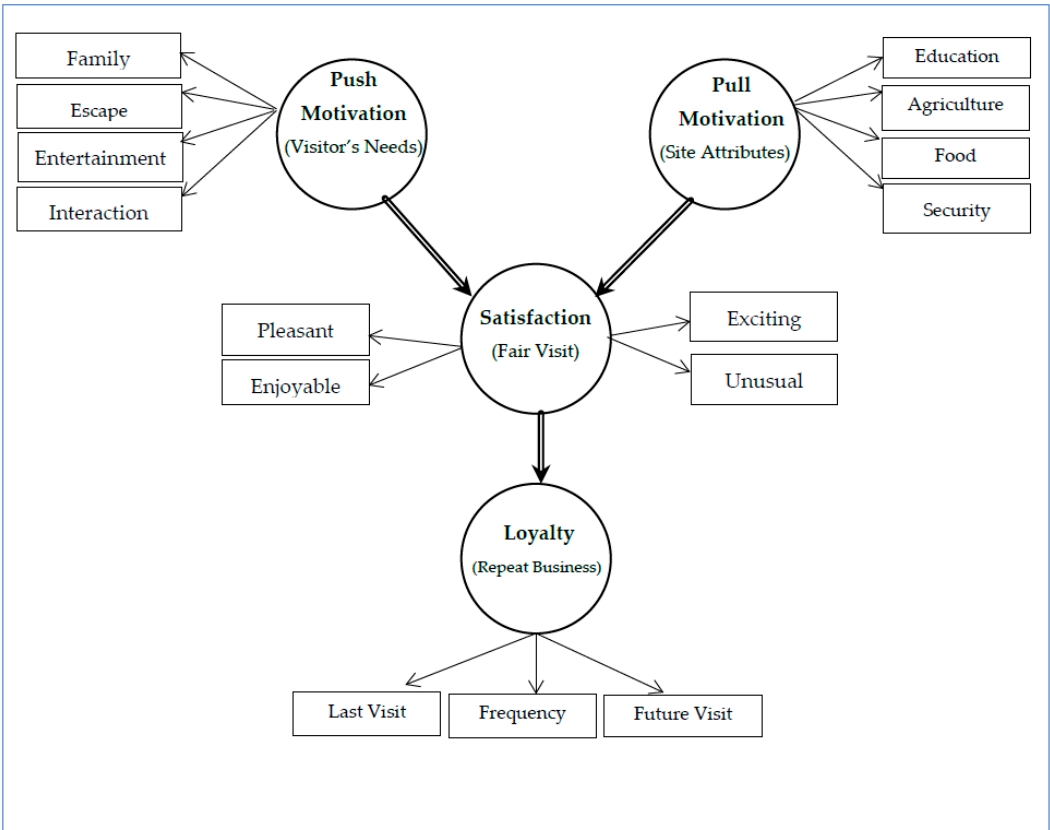
Figure 1. Conceptual model of visitor motivation for attending agricultural